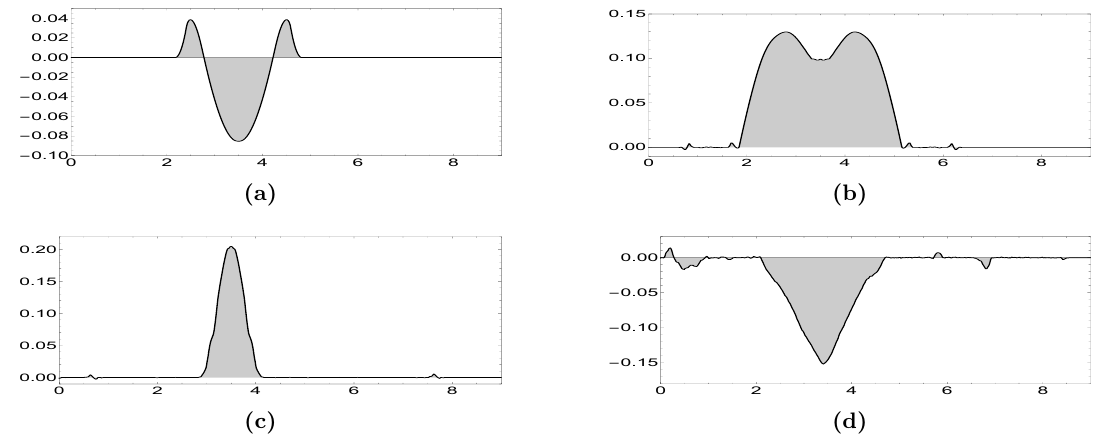
Figure 11. Perturbed breather in the signum-Gordon model on R + for (cid:15) = 3 : 0 at (a) t = 2 : 97, (b) t = 7 : 436, (c) t = 9 : 61, (d) t = 29 :